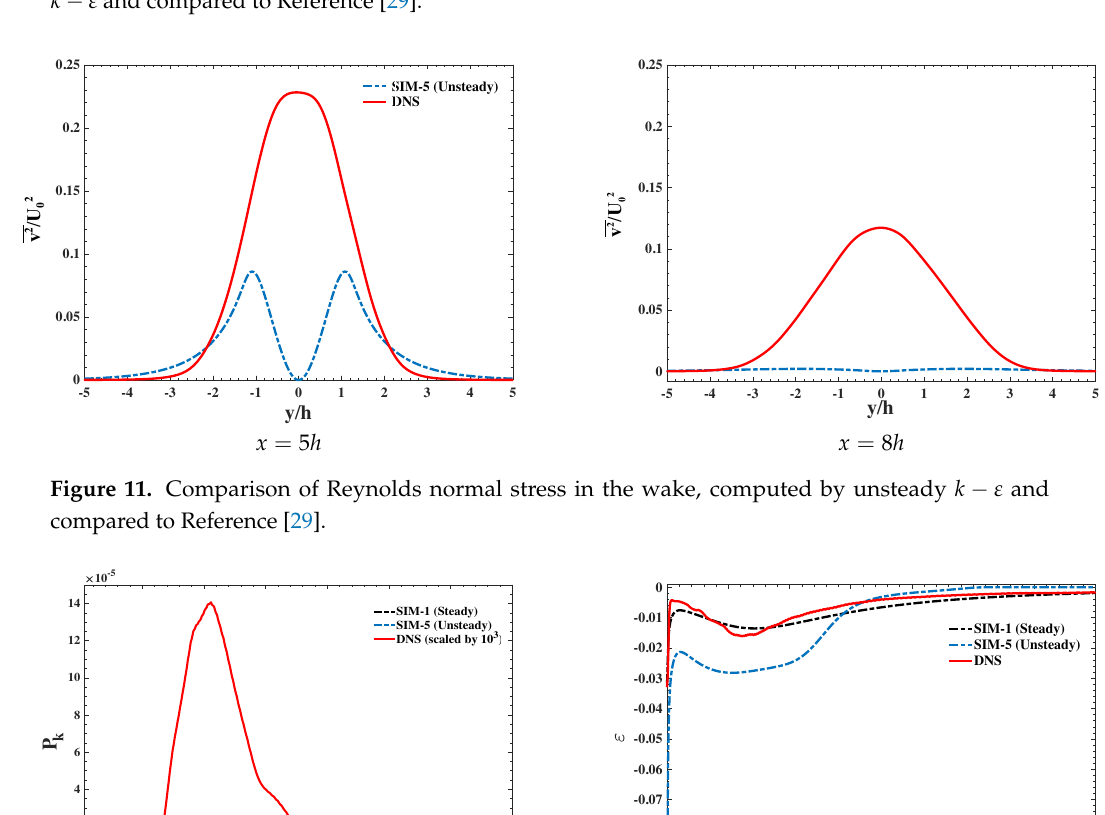
Figure 10. Comparison of the turbulent kinetic energy in the wake, computed by steady and unsteady k − ε and compared to Reference [29].